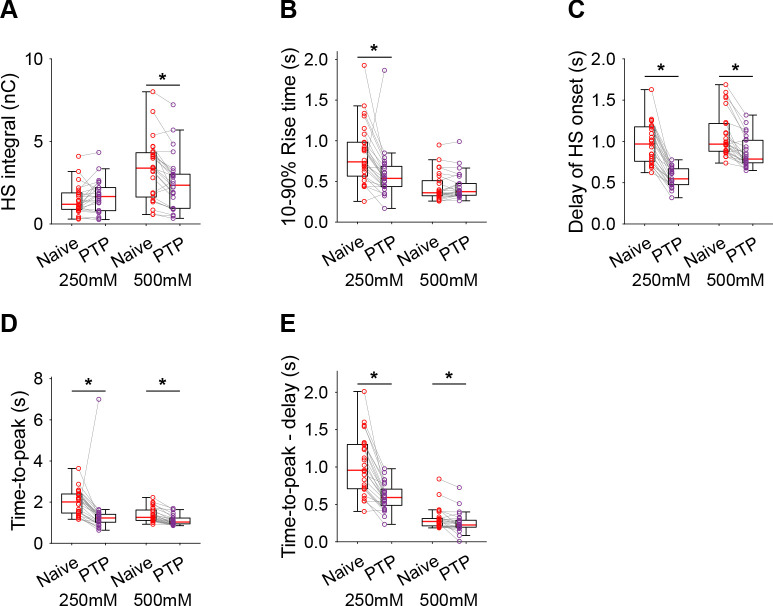
Additional HS parameters before and after PTP in Syt1 KO neurons.(A) Integral of current from HS-induced release at different concentrations. (B) 10–90% rise time of peak HS-induced current. (C) Time delay after application of HS before onset of release. (D) Time from start of HS application till peak HS-induced current. (E) Time from start of HS application till peak HS-induced current, corrected for the delay in release onset after HS application. All panels comparing before (Naive) and after PTP in Syt1 KO (*p<0.05, Wilcoxon signed-rank test).
Figure 5—figure supplement 1—source data 1.Statistics overview.